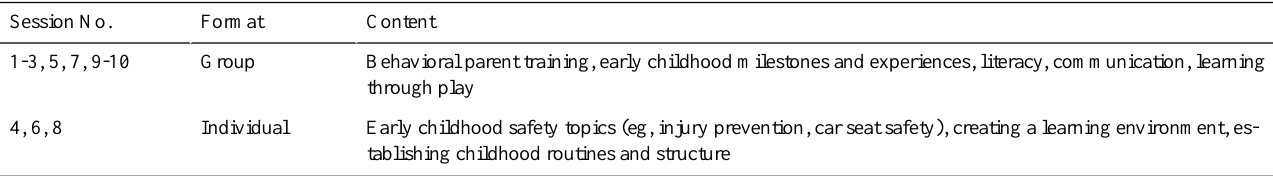
through tablishing childhood routines and